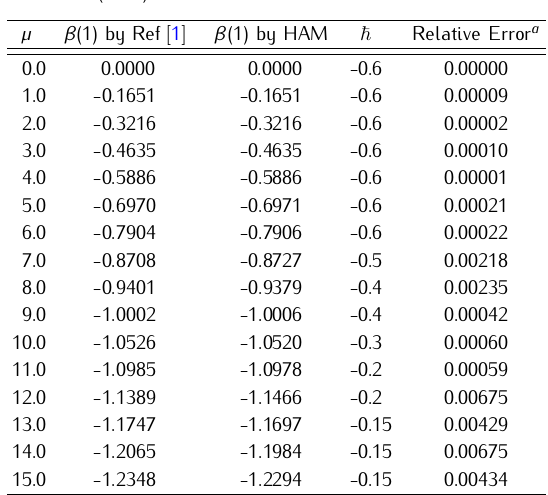
Fig.2. Comparison of convergence for different orders, µ=5, (a)